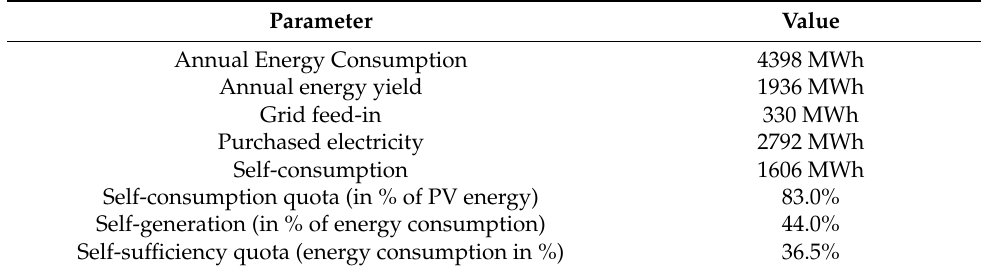
Table 4. Distribution of PV energy and